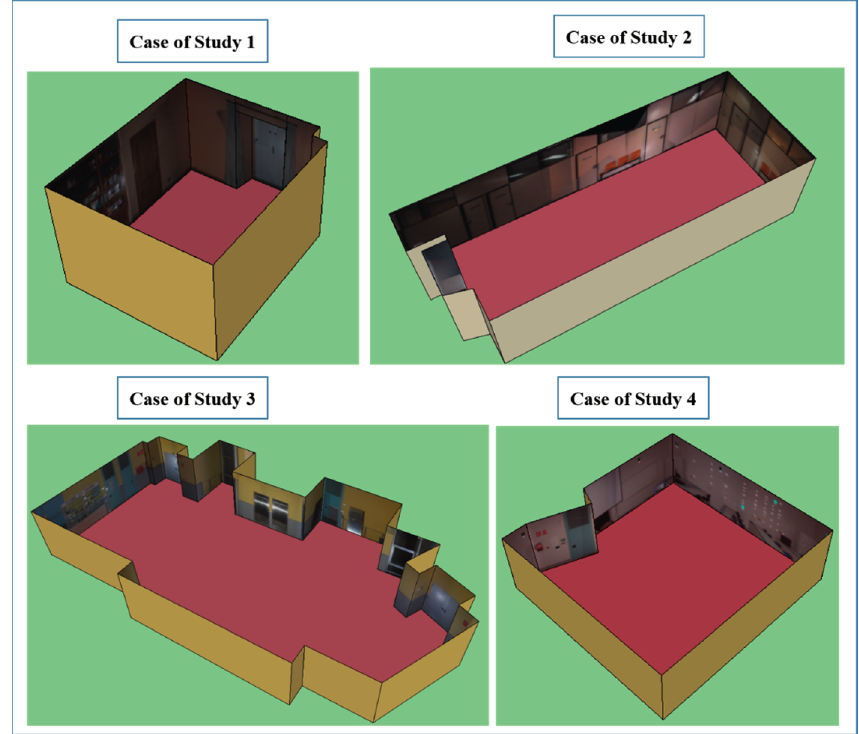
Figure 15. 3-D building interiors are exported to Sketchup © with the resulting